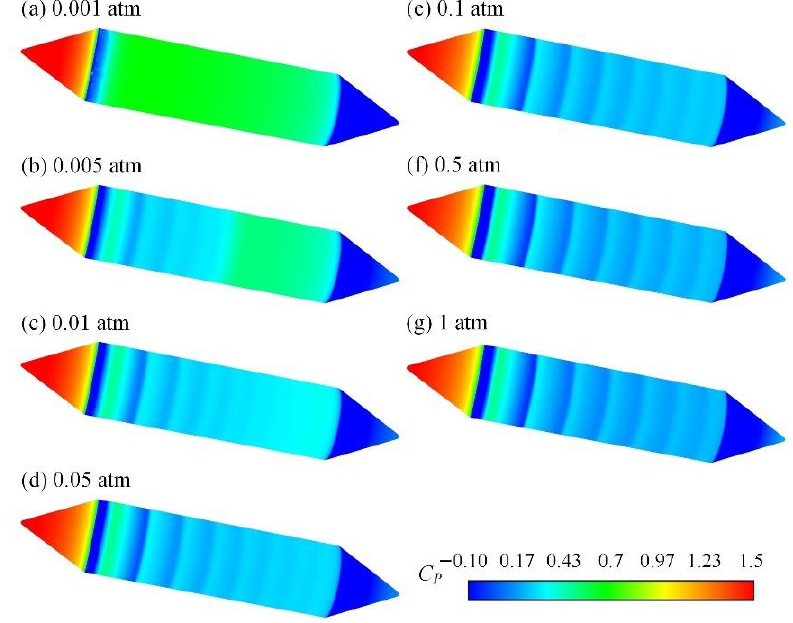
Figure 17. C P contours on the surface of tube train.